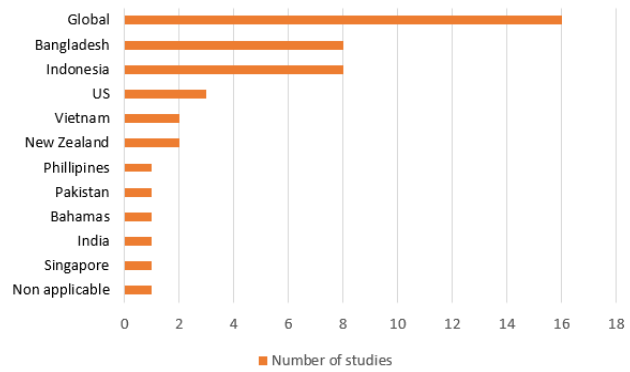
Figure 2. Coverage of studies by countries.